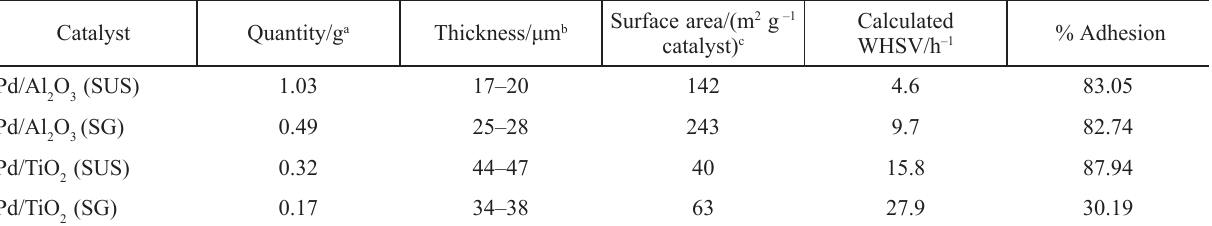
Table 2 – Quantity, thickness, surface area, calculated WHSV, and %adhesion of the prepared Pd-supported catalysts